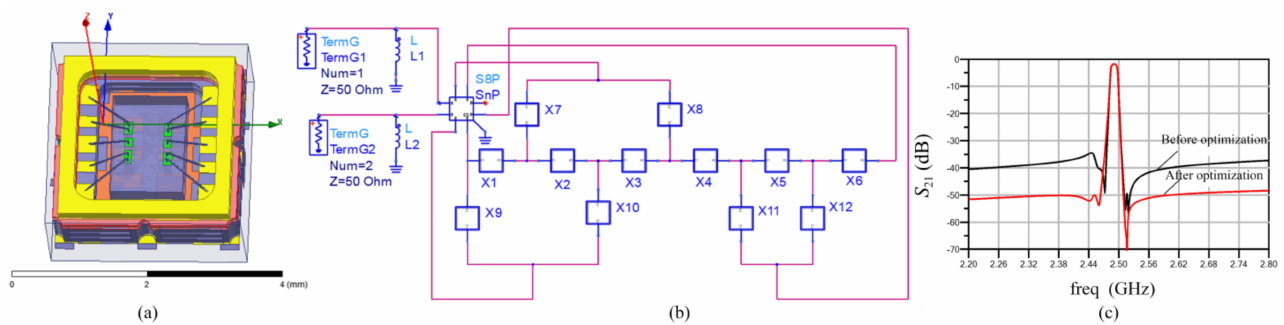
Figure 1. ( a ) Mason model of the TC-FBAR. ( b ) Simulated displacement field at the resonant frequency of TC-FBAR.